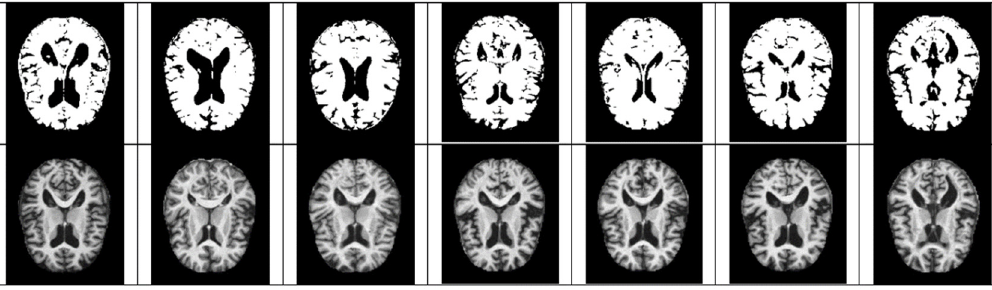
Figure 4. Quantized non examples ( above ), original very mild examples ( below ).